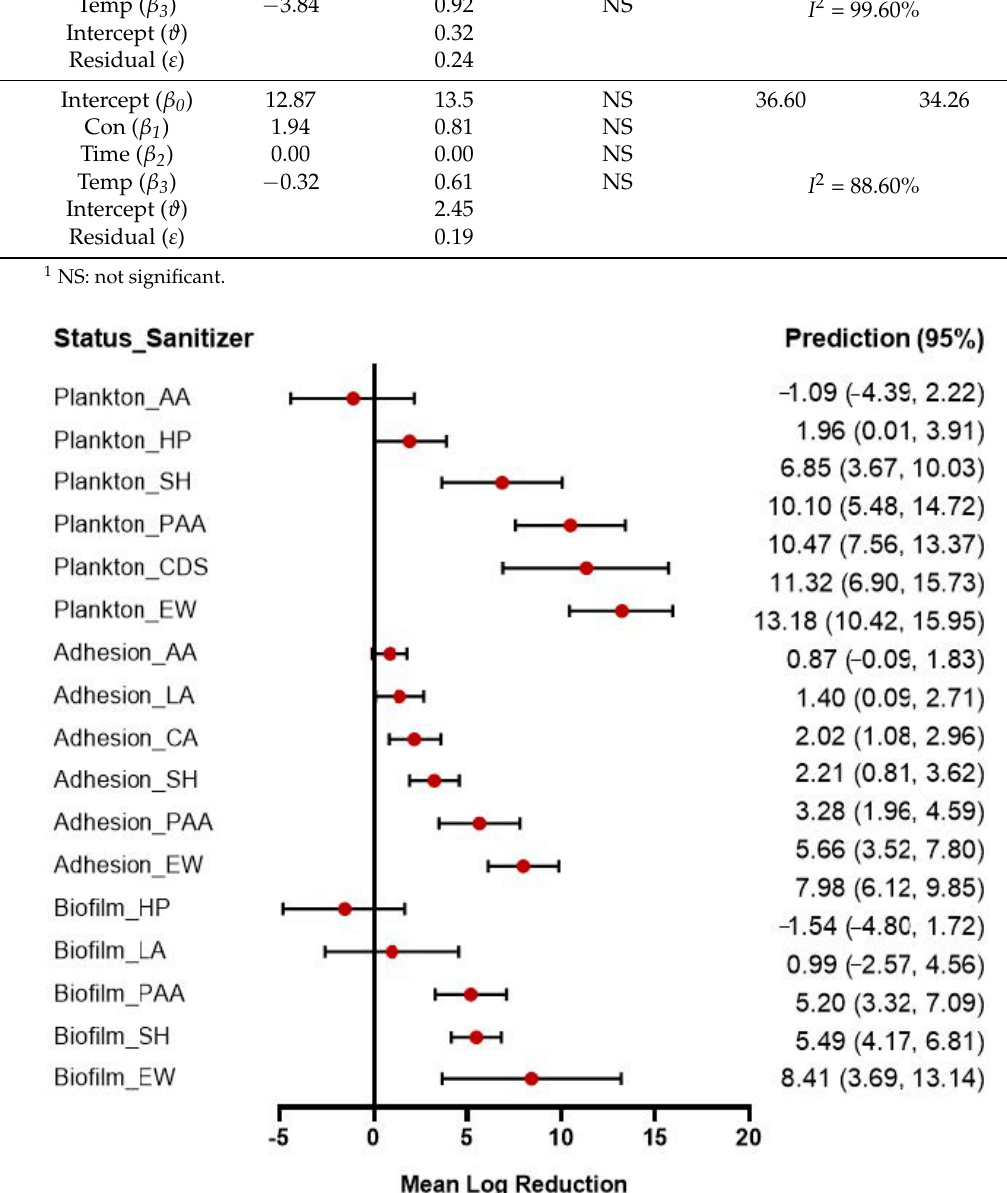
Figure 3. Forest plot of the predicted log reduction of L. monocytogenes in plankton, adhesion, and biofilm statuses using a common hypothetical treatment of 1% sanitizers at 15 min, 25 °C.